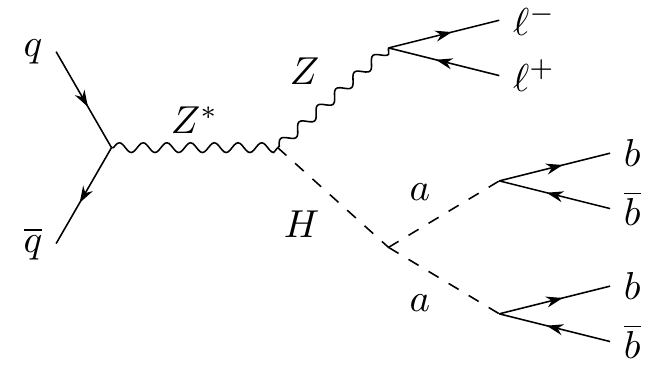
Figure 1 . Tree-level Feynman diagram representing ZH production with H → aa → b ¯ bb ¯ b